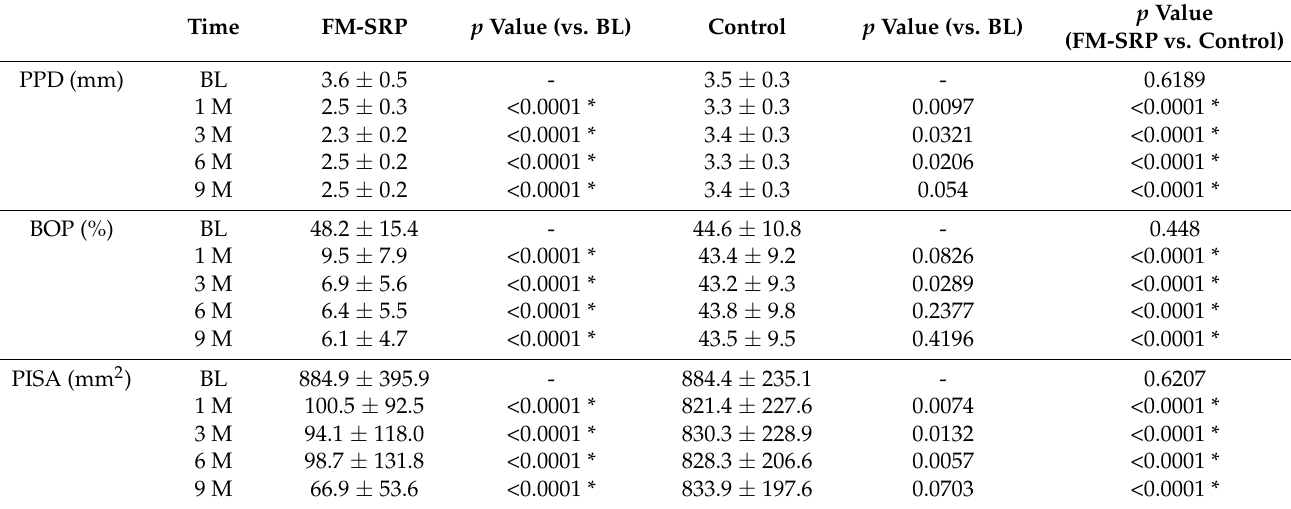
Table 2. Clinical